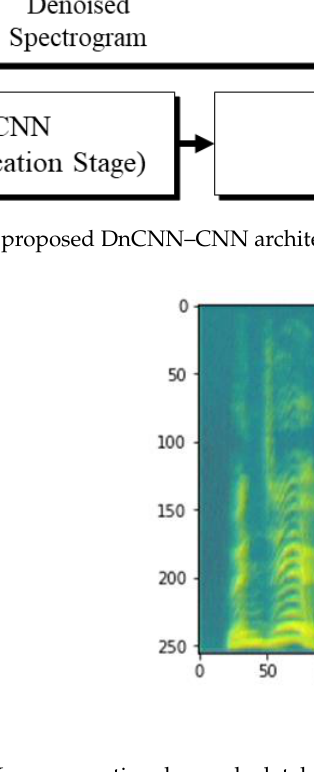
Table 1. Structure of the proposed cascaded DnCNN–CNN.